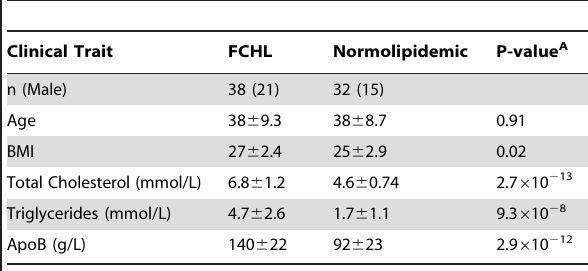
Table 1. Clinical characteristics for Mexican FCHL fat